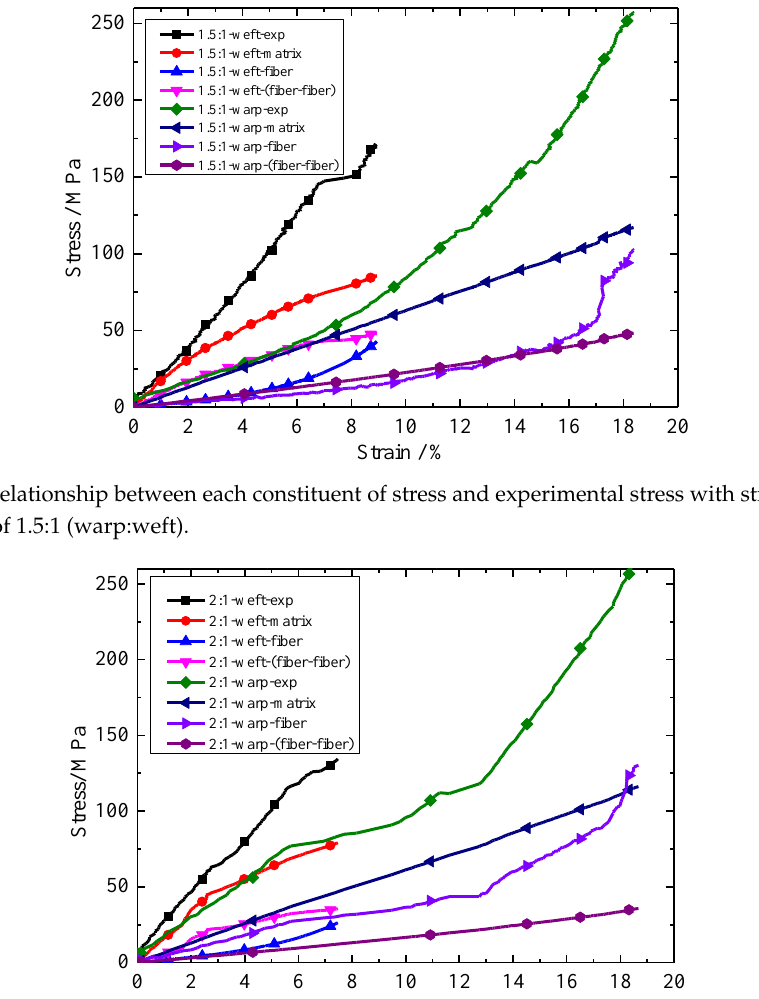
Figure 12. Relationship between each constituent of stress and experimental stress with strain under a stress ratio of 2:1 (warp:weft).